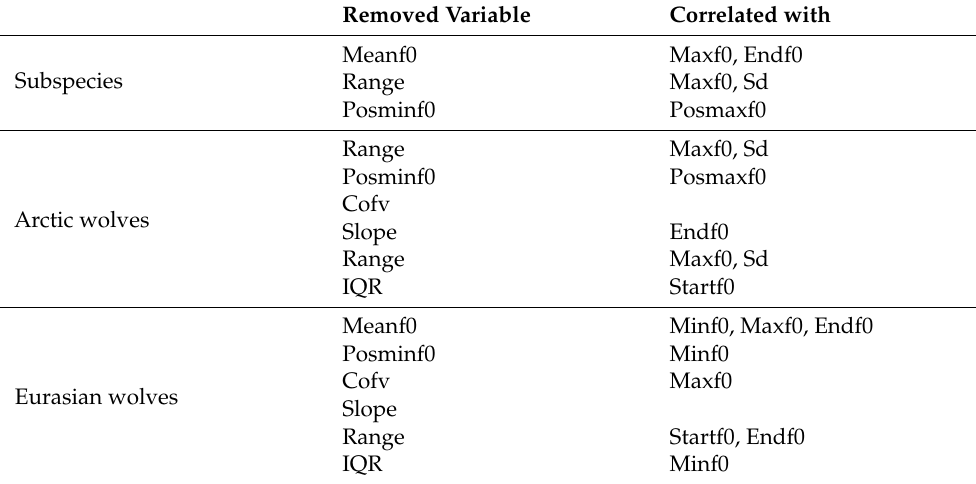
Table 3. Removed variables and the variables they were correlated with from Pearson correlation test both for the analysis of Subspecies and for the analysis of individual identification within the two subspecies: Arctic and Eurasian wolves. Removed Variable Correlated with Subspecies